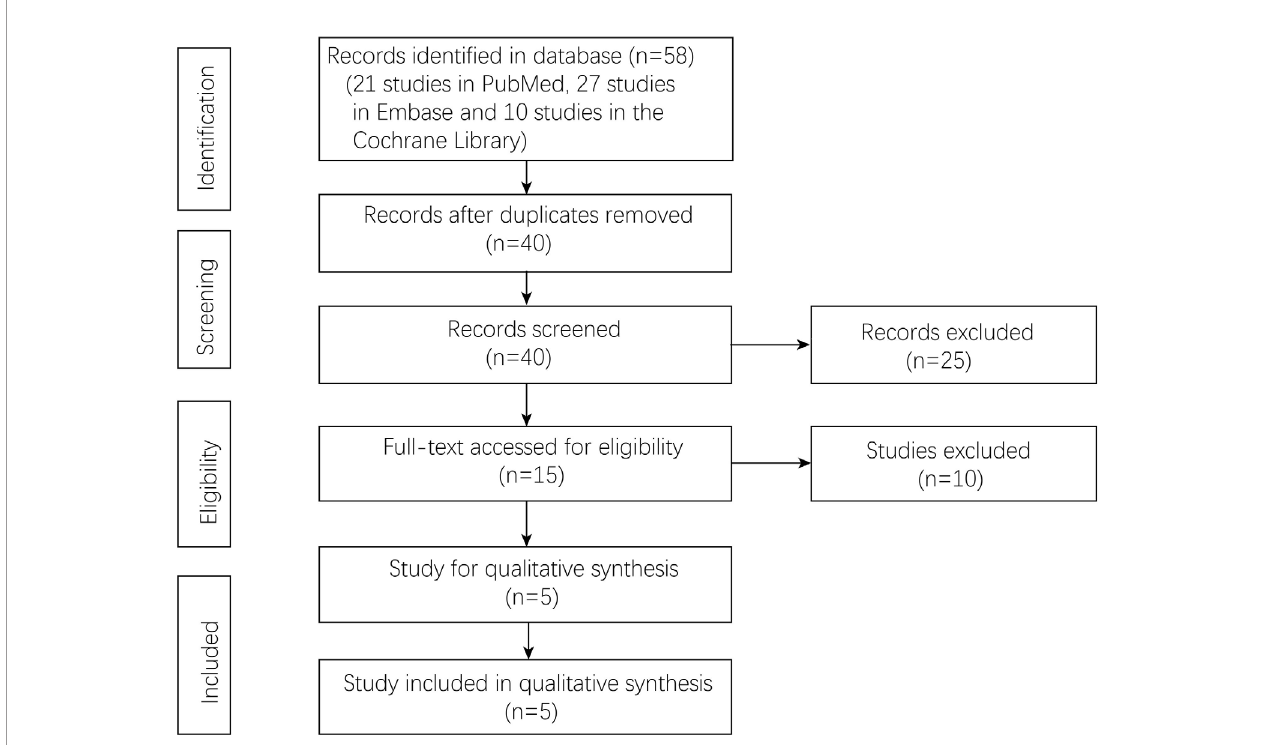
FIGURE 1 | Flowchart of study selection.